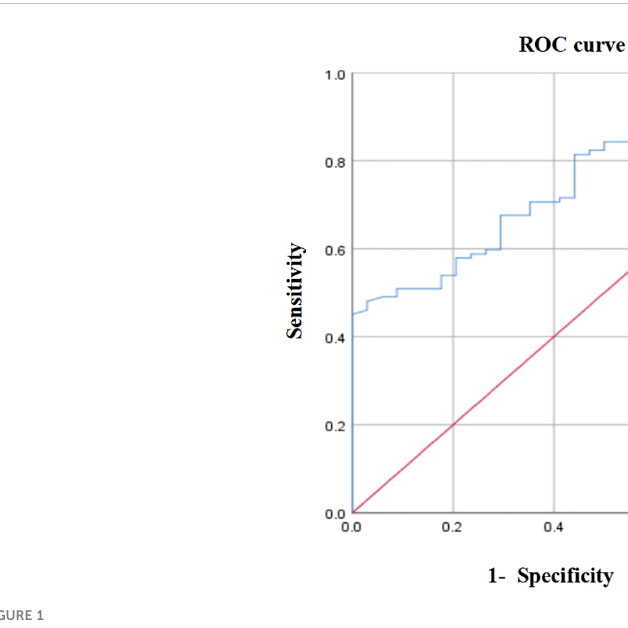
FIGURE 1 The optimal cut-off value of PNI.